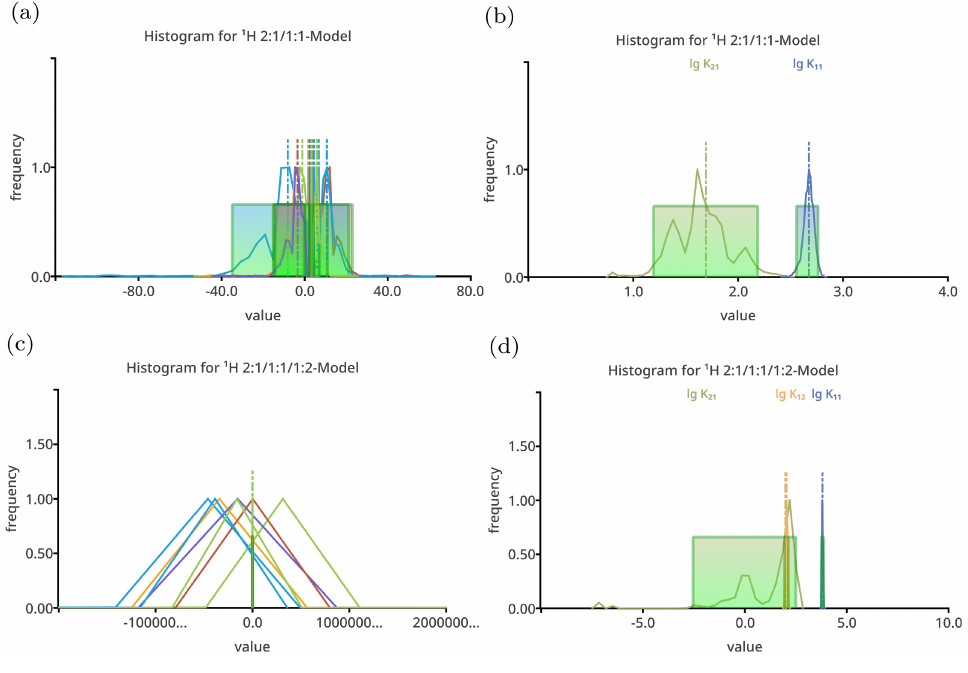
Figure 2 Histogram like charts after performing Monte Carlo simulation on top of the best-fit 2:1/1:1 model (A, B) and the best-fit 2:1/1:1/1:2 model (C, D) fitted to the simulated titration curve with 1:1/1:2 stoichiometry. The charts (A) and (C) show all model parameters, the dimensionless stability constants as log10 and chemical shifts [ppm], while the charts (B) and (D) show only the stability constants. The distribution of the individual parameters—especially the distribution of the chemical shifts—is broad. Hiding the chemical shifts, the distribution of the appropriate stability constants is revealed to be comparable narrow, in particular the distribution of lg K 11 in the 2:1/1:1 model . The distribution of the lg K 11 gets worse changing the 2:1/1:1 model to the more complex 2:1/1:1/1:2 model . Full-size DOI: 10.7717/peerjachem.23/fig-2